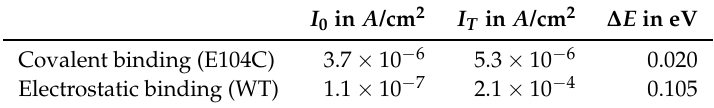
Table 3. Parameter values reproducing the Cytochrome C measurement results of [27]